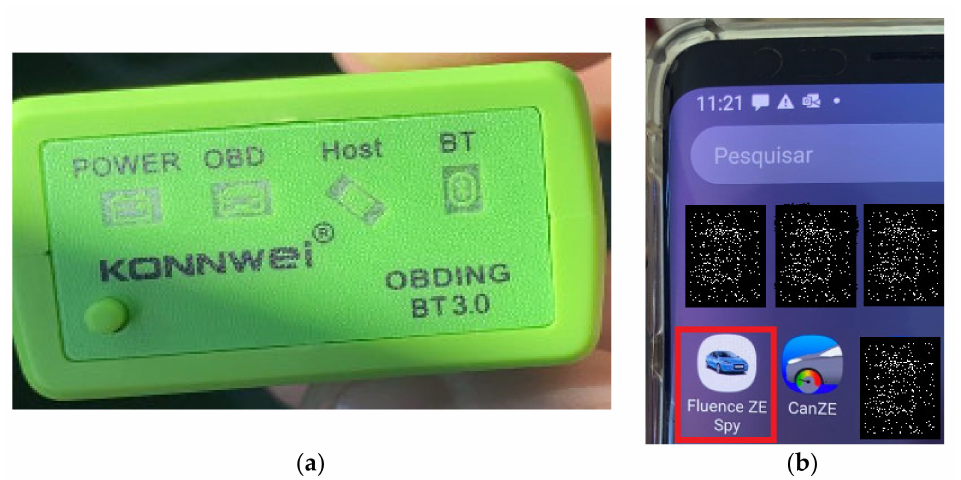
Figure 4. Required gadget and software: ( a ) Scanner Konnwei OBDING BT 3.0, model KW902; ( b ) Fluence ZE Spy